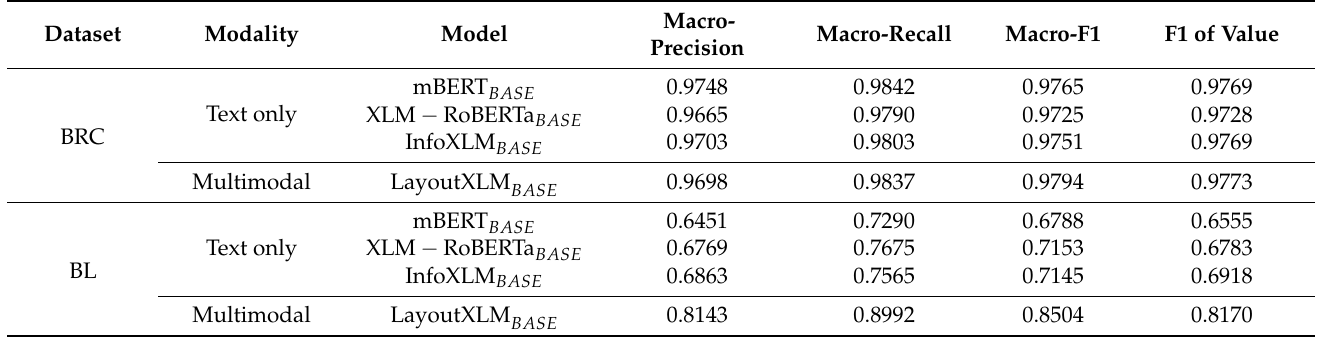
Table 3. Performance of key information extraction without key labels.